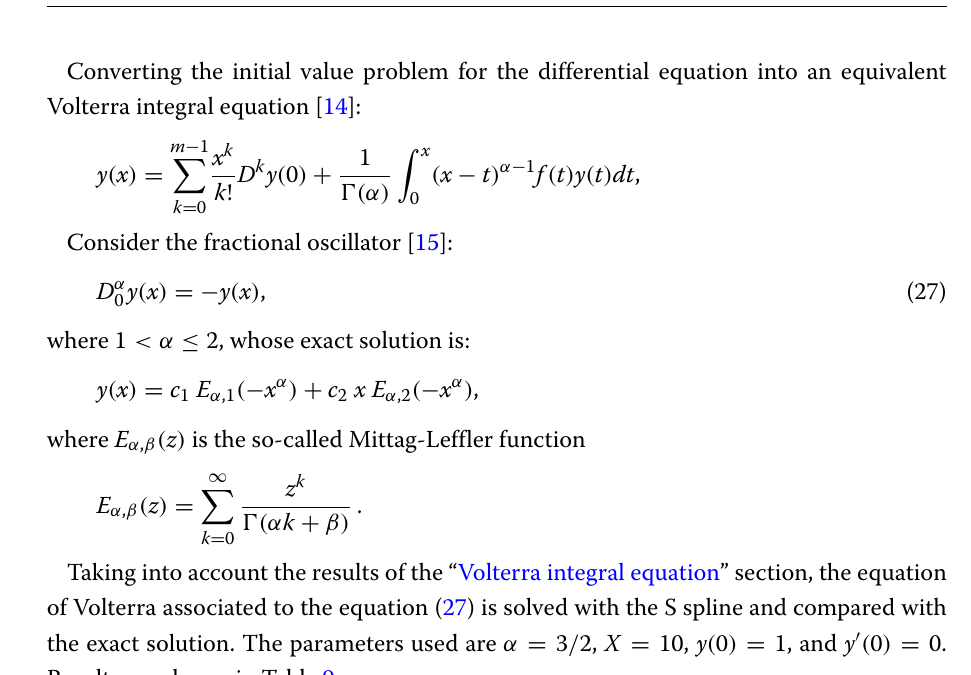
Table 8 Errors e n and E T with the S spline for (24) n 5 e n ( S )